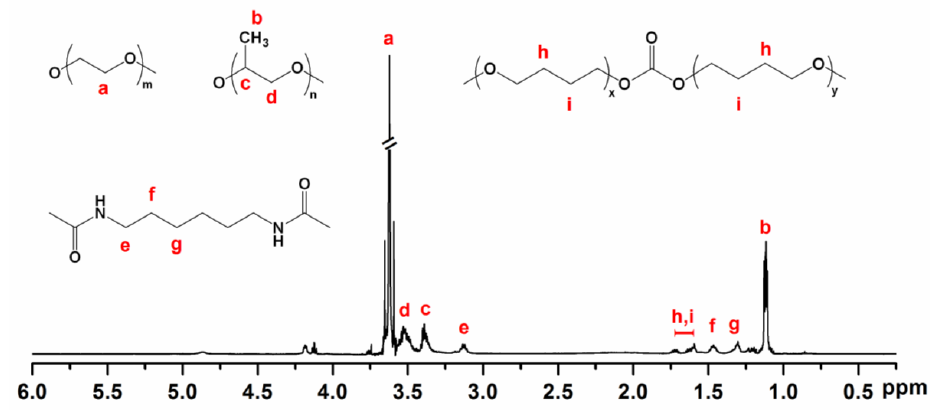
Figure 2. 500 MHz 1 H NMR spectroscopy of copolymer P2 in CDCl 3 .